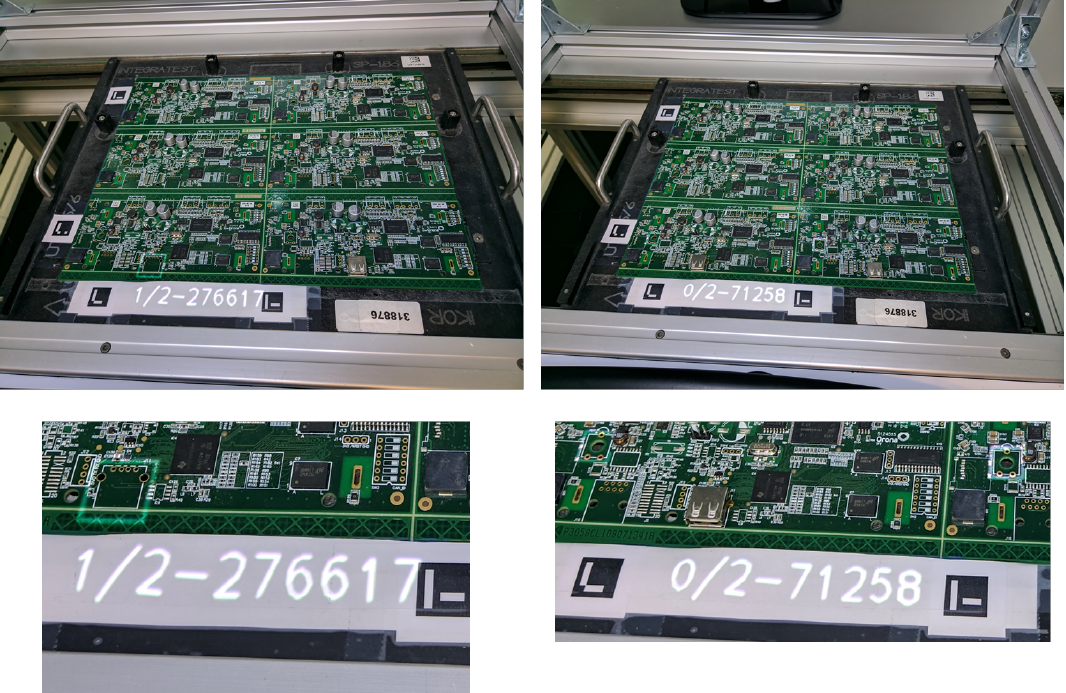
Figure 6. Example of virtual content that is projected (highlighted in white) in the printed circuit board during the component assembly process. The projection is more clearly seen live, so we provided the bottom row that has zoomed-in versions of the top images to see the projections in these images with more